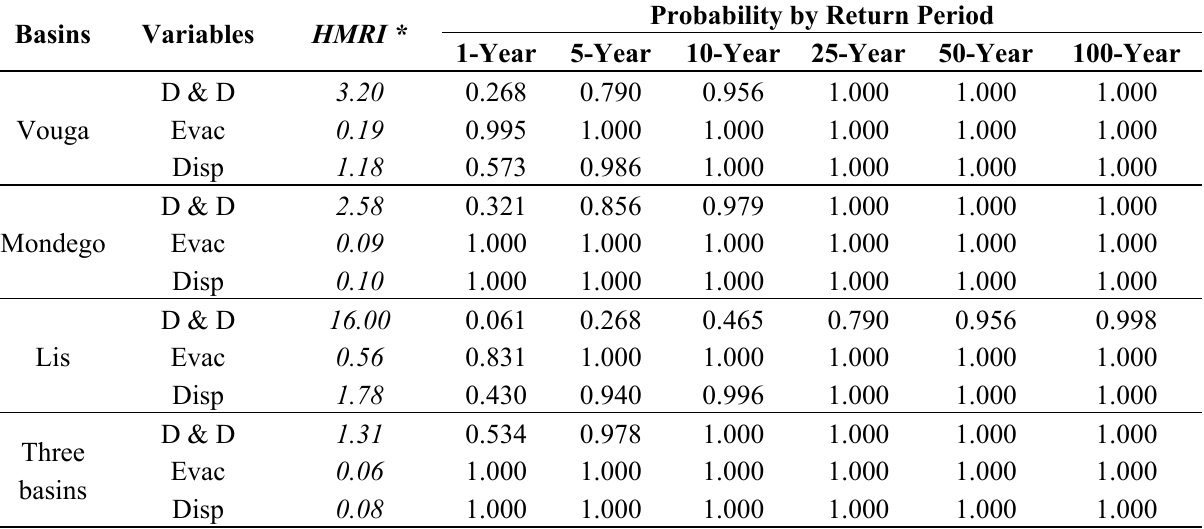
Table 5. HMRI and probability from 1 to 100 year return period of having at least one D & D, one evacuated and one displaced